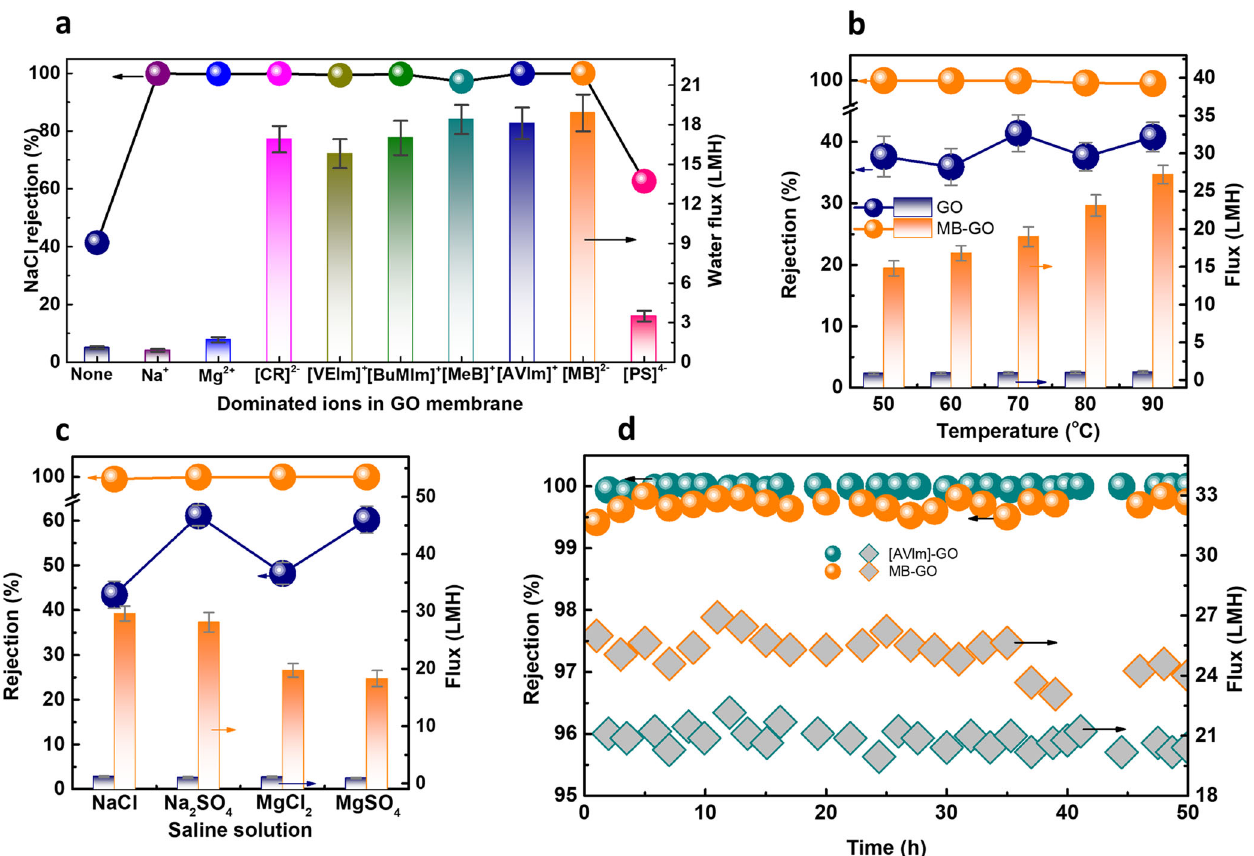
Fig. 3 Desalination behaviors on organic ion-GO membranes. a Effects of cation or anion intercalation on the desalination performance of GO-based membranes (pervaporation conditions: P = ~200 Pa, T = 70 °C, C NaCl = 3.5 wt%). b Temperature dependence of desalination with GO membrane and MB-GO membrane ( P = ~200 Pa, C NaCl = 3.5 wt%). c Effects of ionic valence on the desalination with GO and MB-GO membranes ( P = ~200 Pa, T = 70 °C, C salt = 3000 ppm, the same legends as that in Fig. 2b). d Long-term stabilities of MB-GO and [AVlm]-GO membranes for desalination (( P = ~200 Pa, T = 70 °C, C NaCl = 1 wt%). The error bars in ( a – c ) are the standard error of the mean